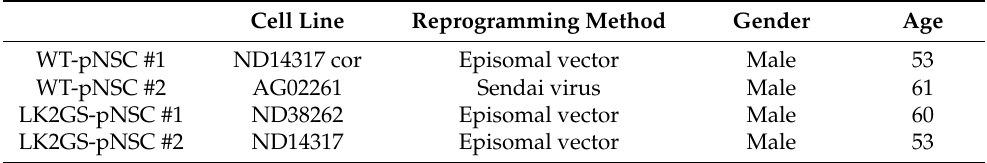
Table 1. List of cells used in this study.